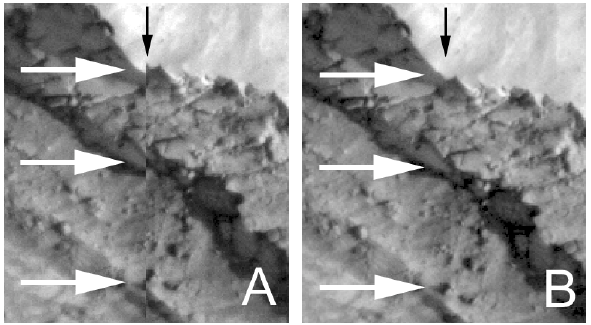
Figure 9. Seam (black arrows) between CCD strips in ESP 019988 1750. White arrows indicate places where obvious features are misaligned in A, and where those feature are now well aligned across the seam in B, which has been processed through HiJACK.